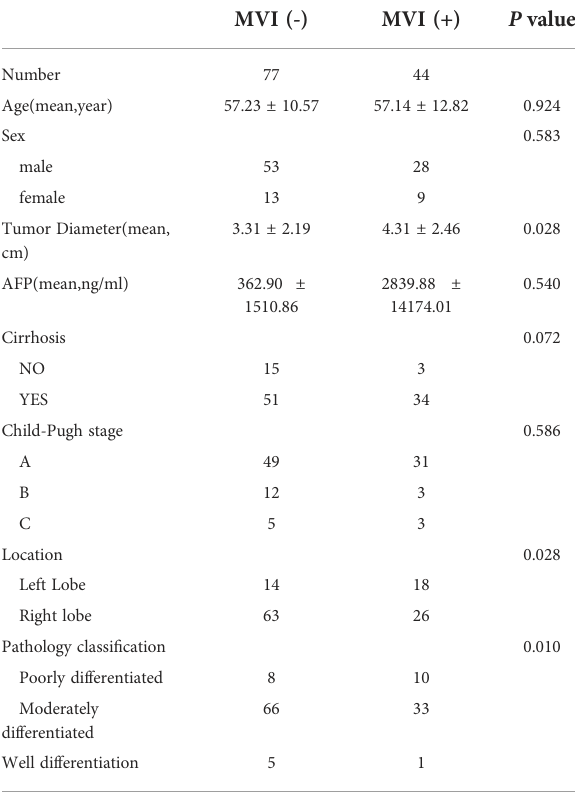
TABLE 1 Clinical characteristics of 103 patients and MVI pathological features of